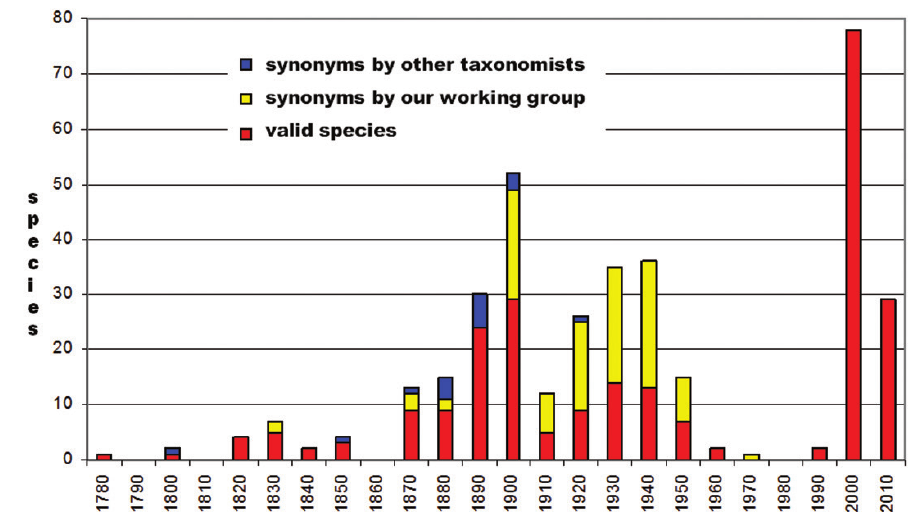
Figure 1. Numbers of described species of Afrotropical Galerucinae s. str. per decade revised between 2000 to 2016 by our working group with synonyms